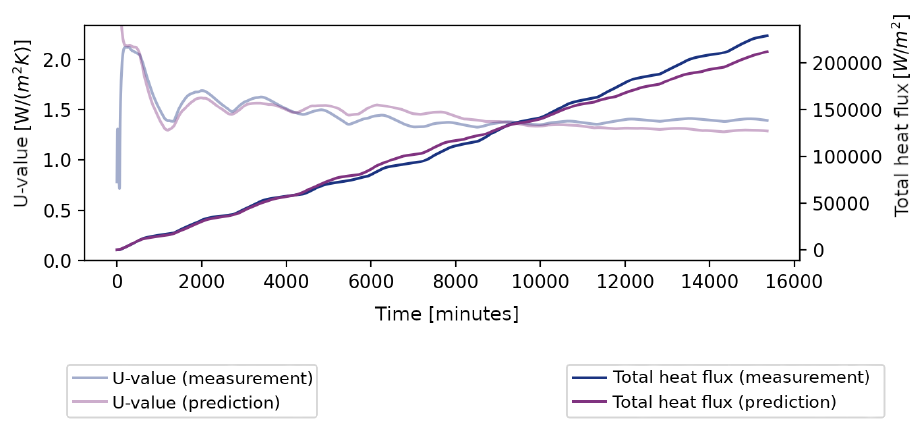
Figure 11. U -value and total heat flux comparison calculated on measured and predicted values for pilot in-situ measurement.